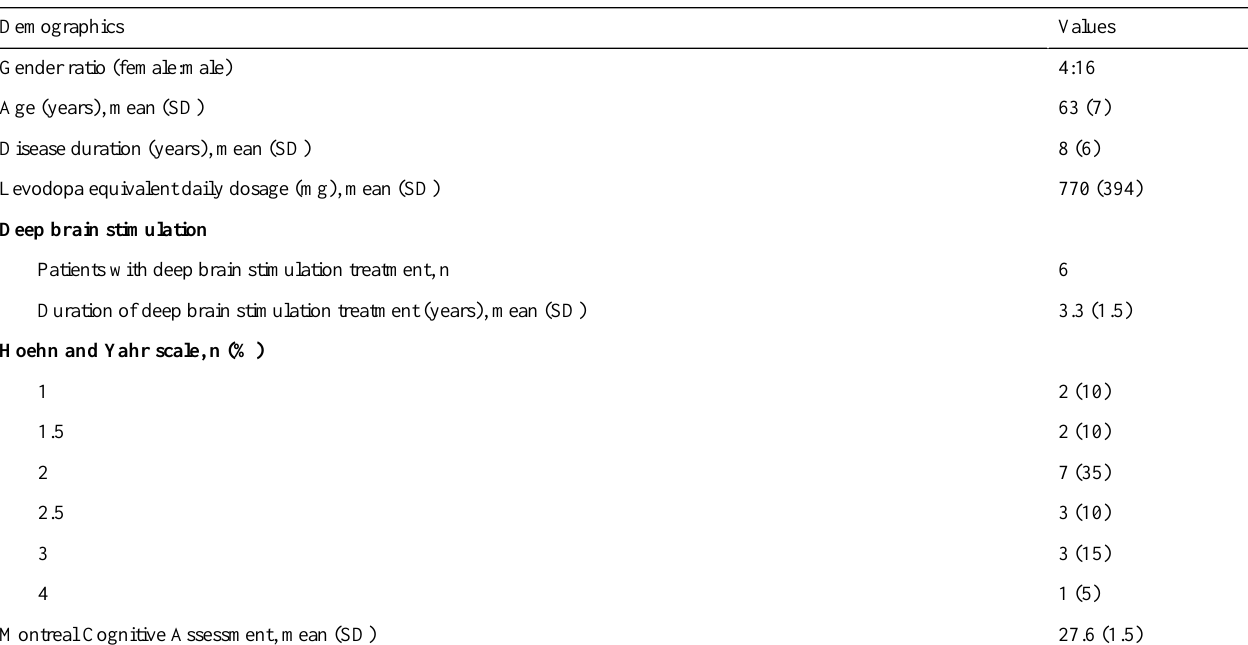
Table 1. Demographics of study population.